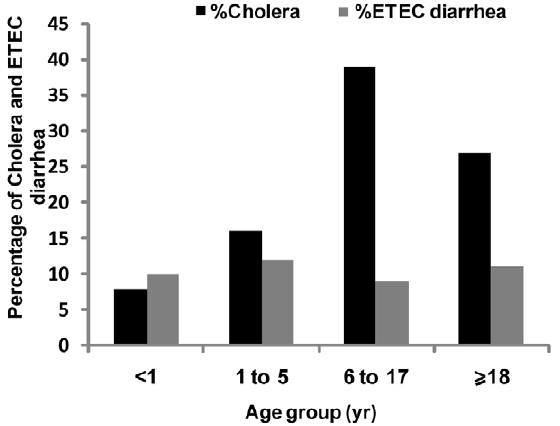
Figure 3. Cholera and ETEC hospitalization rate among the patients of different age group coming from Mirpur area.